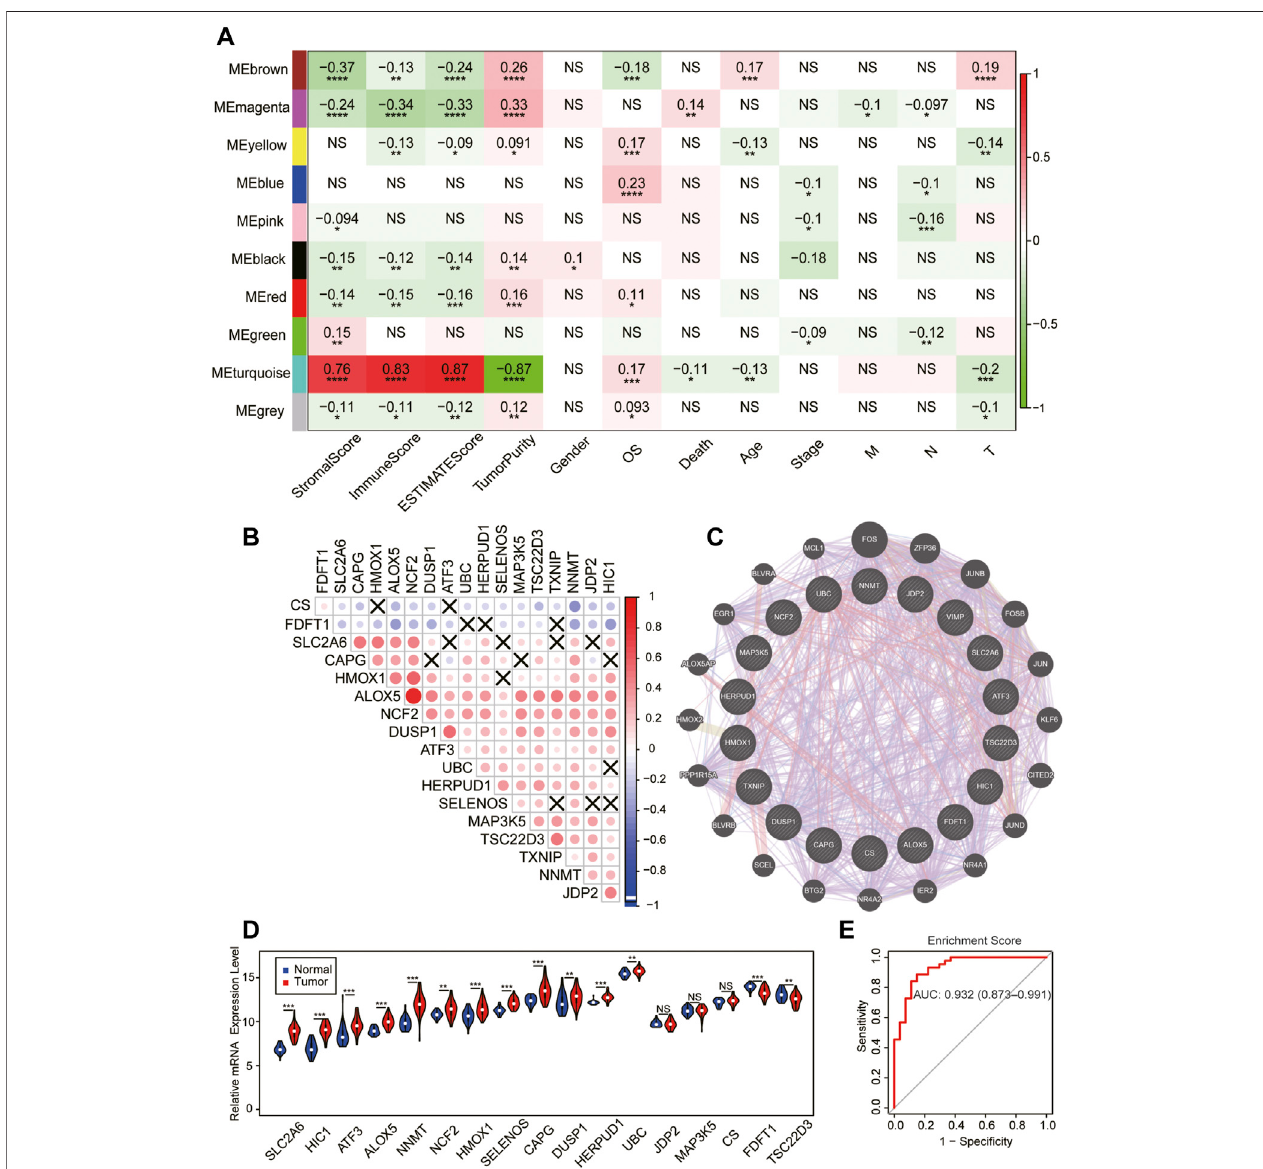
FIGURE2| Identi fi cationofthekeymoduleofferroptosisinSKCM. (A) Thegene – moduletraitrelationshipbasedontheweightedgenecorrelationnetworkanalysis (WGCNA) in SKCM. (B) The mRNA expression correlation heatmap of the turquoise module – gene in the TCGA database. X, no signi fi cant correlations. (C) Weighted interactionnetworksofgenesintheturquoisemoduleperformedbyGENEMANIA. (D) Differentialexpressionof17module – genebetweennormalandtumortissueinthe GSE98394 database. The violin fi lling in red represents tumor samples, while blue represents normal tissues. (E) The ROC curve of the enrichment score in the GSE98394 database. * p < 0.05; ** p < 0.01; *** p < 0.001; and **** p < 0.0001 was determined by the Spearman analysis and the Wilcoxon rank-sum test in